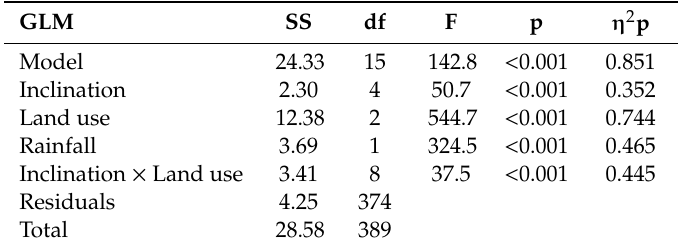
Table 6. Summary of the General Linear Model (GLM) performed with soil erosion as the target variable (SS: sum of squares, df: the degree of freedom, F: F-statistic, p: significance, η 2 p: e ff ect size; p < 0.001 is highlighted in bold).